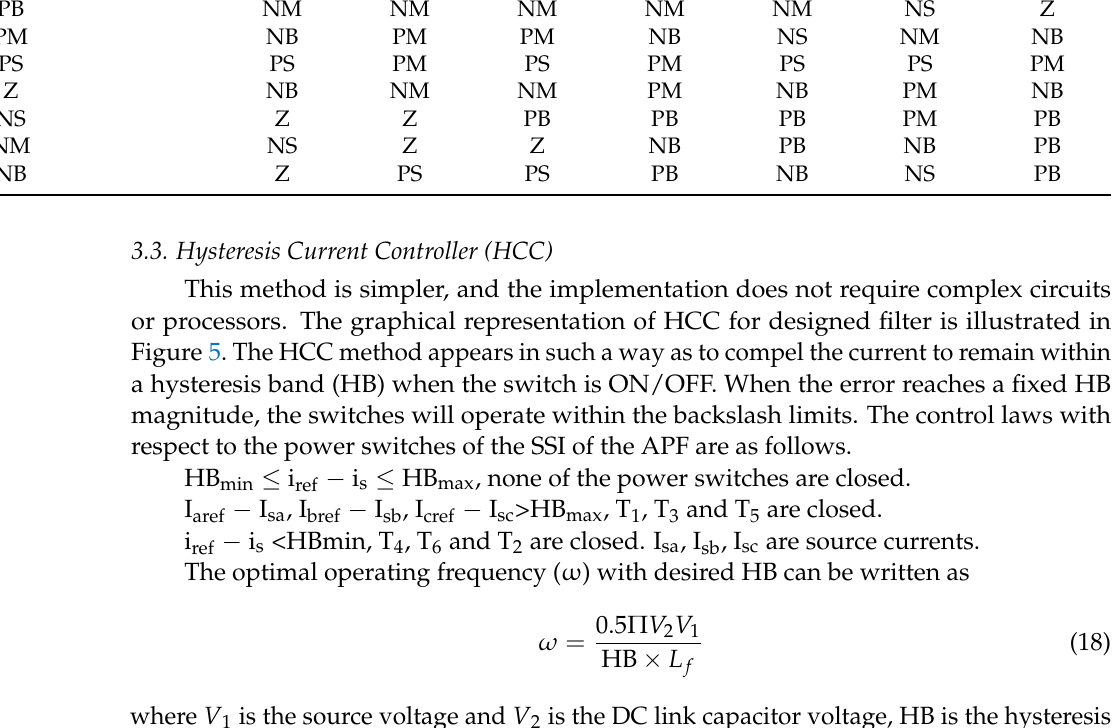
Figure 4. Sugeno method FLC structure with membership functions. ( a ) Error in voltage (e), ( b ) change in error voltage (ce).